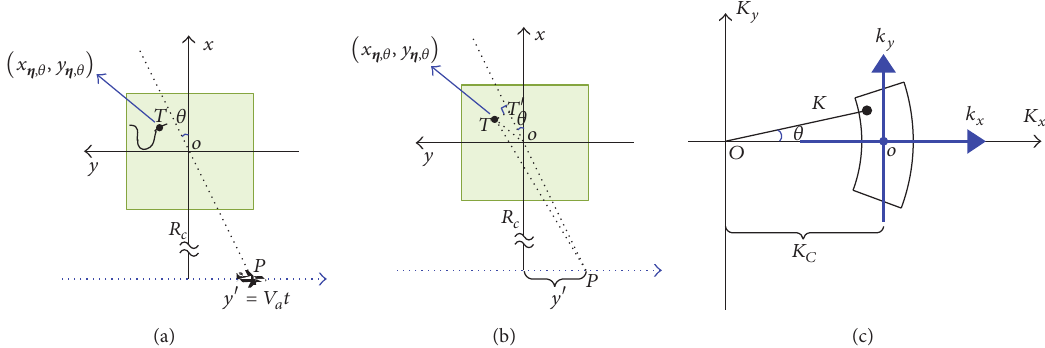
Figure 1: Spotlight SAR moving target geometry: (a) slant plane view; (b) plane wave approximation; (c) wavenumber-domain view.